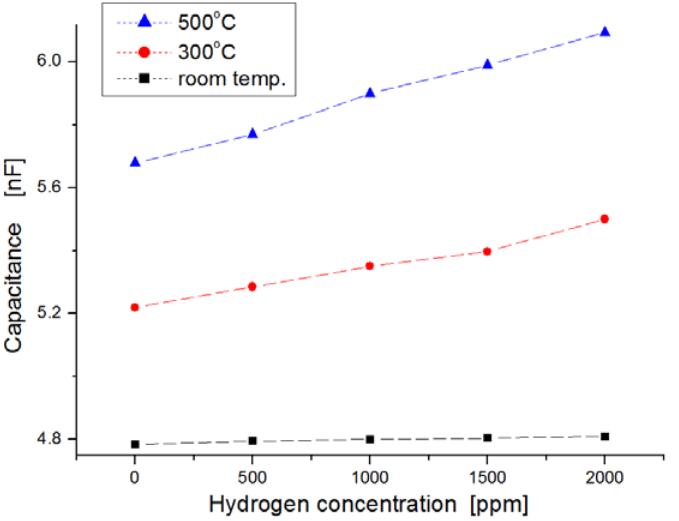
Figure 7. Dependence of capacitance on hydrogen concentrations as a function of